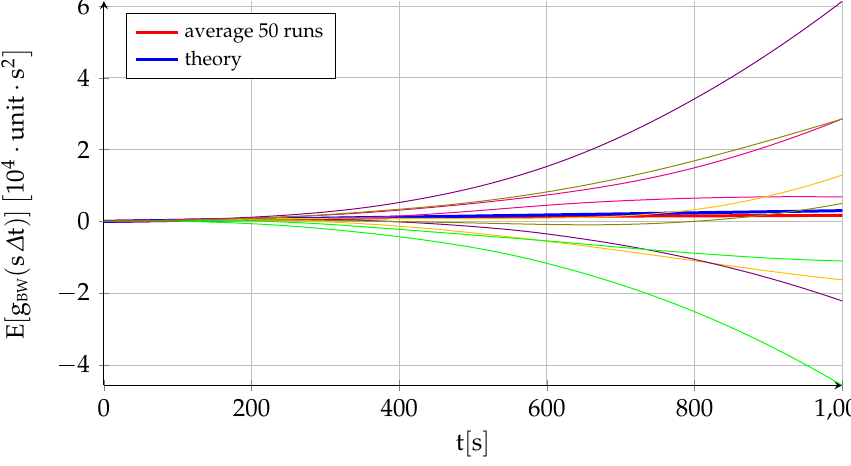
Figure 6. Propagation with time of second integral of sensor error